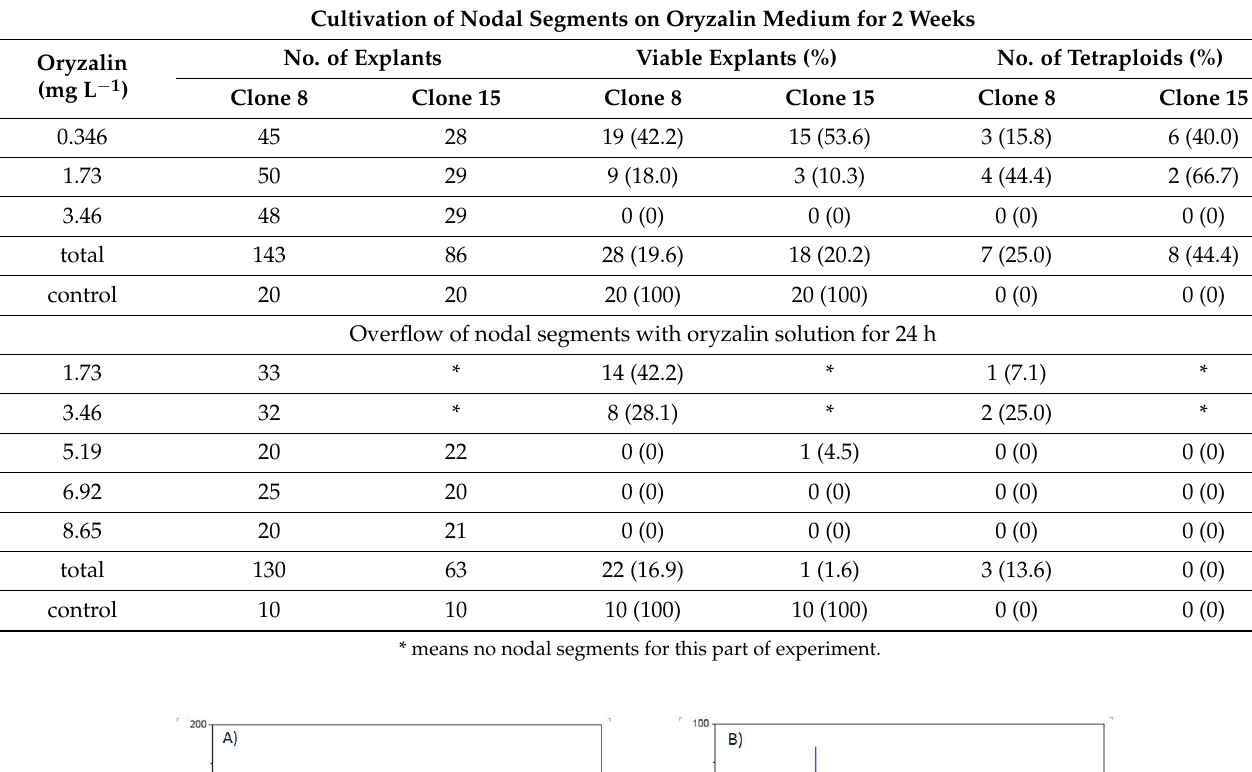
Table 1. Numbers of thyme tetraploids obtained from in vitro polyploidization using two methods: (1) cultivation of nodal segments on oryzalin medium for two weeks and (2) overflow of nodal segments with oryzalin solution for 24 h. Cultivation of Nodal Segments on Oryzalin Medium for 2 Weeks